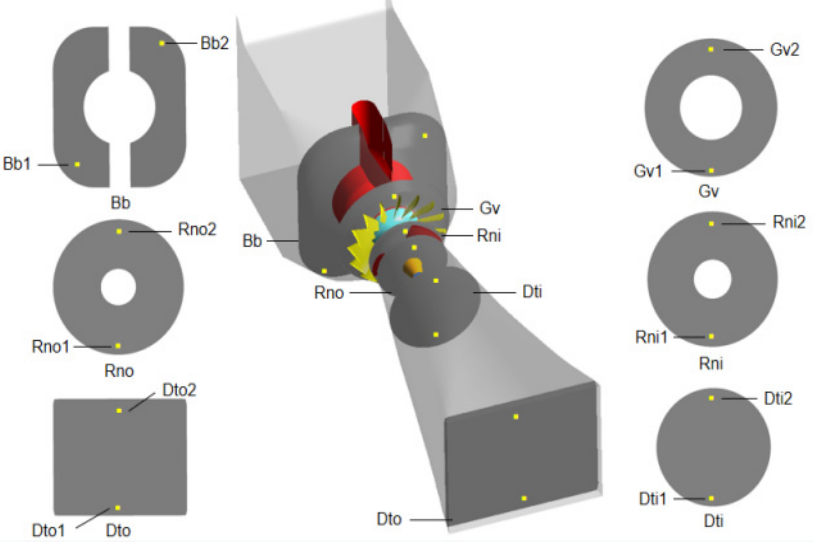
Figure 9. Schematic of important sections and monitoring points. Figure 10 shows the pressure fluctuation distribution of each flow passage component of the tubular turbine under different conditions. The pressure of the turbine structural components increases with the increase in water depth due to the influence of hydrostatic pressure. The pressure at the top of the flow passage is small, whereas the pressure at the bottom of the flow passage is large. The pressure difference between the top and bottom of different flow passages is positively related to the elevation difference. Under the same conditions, the pressure fluctuation laws of the two pressure-monitoring points on the same section are the same. With the decrease in the head, the pressure fluctuation law becomes increasingly complex at the same section. Taking the runner inlet as an example, the pressure fluctuation at the runner inlet is typical sinusoidal fluctuation at the 7.7 m head of condition one. With the decrease in the water head, such as H = 6.08 in condition two and 4.6 m in condition three, a small second fluctuation period with an amplitude and period less than the main wave appears during the development from trough to peak. The lower the water head, the more obvious the period and amplitude of the secondary fluctuation. The vibration characteristics of the runner area become more complex with the decrease in the water